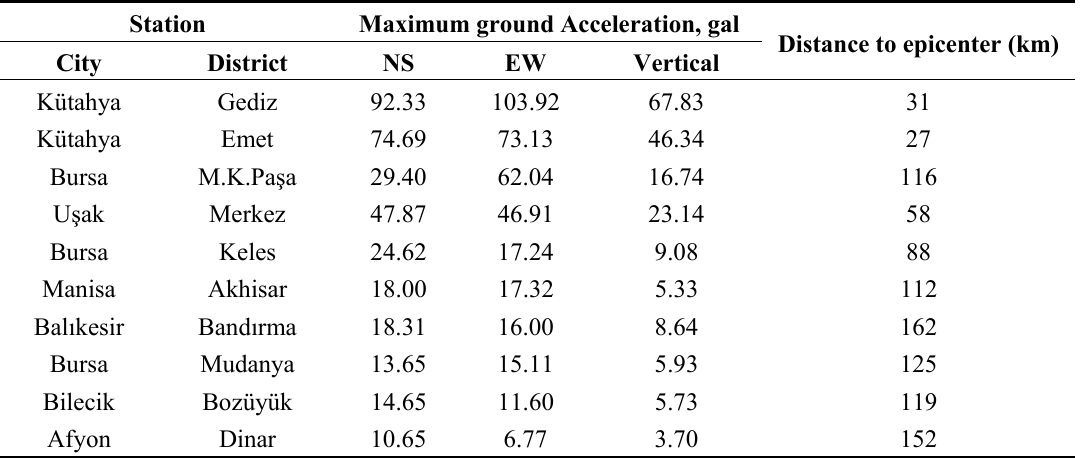
Table 3. Maximum ground accelerations measured during the May 19 Simav